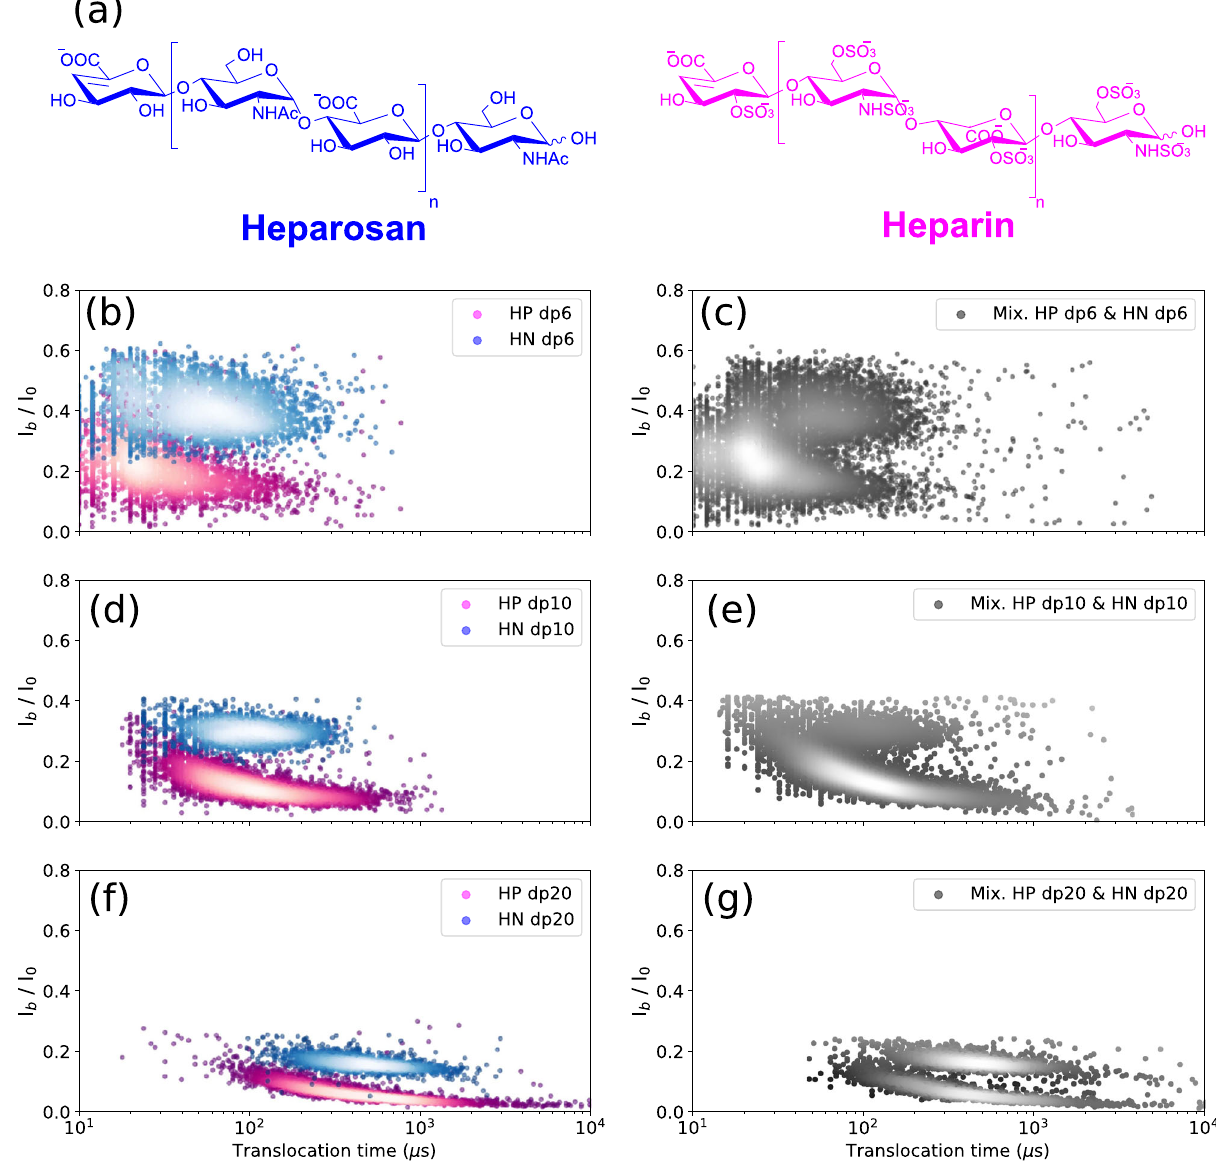
Fig.4|Discriminationofthenon-sulfatedheparosanandfullysulfatedheparin oligosaccharides analyzed individually and in mixture. a Structures of the heparosanandheparin.Superimposedscatterplotsof b HNdp6andHPdp6, d HN dp10andHPdp10,and f HNdp20andHPdp20.Scatterplotofthemixtureof c HN dp6 and HP dp6, e HN dp10 and HP dp10, and g HN dp20 and HP dp20. Dis- crimination betweenHPandHNoligosaccharides ineach size class is observed. All